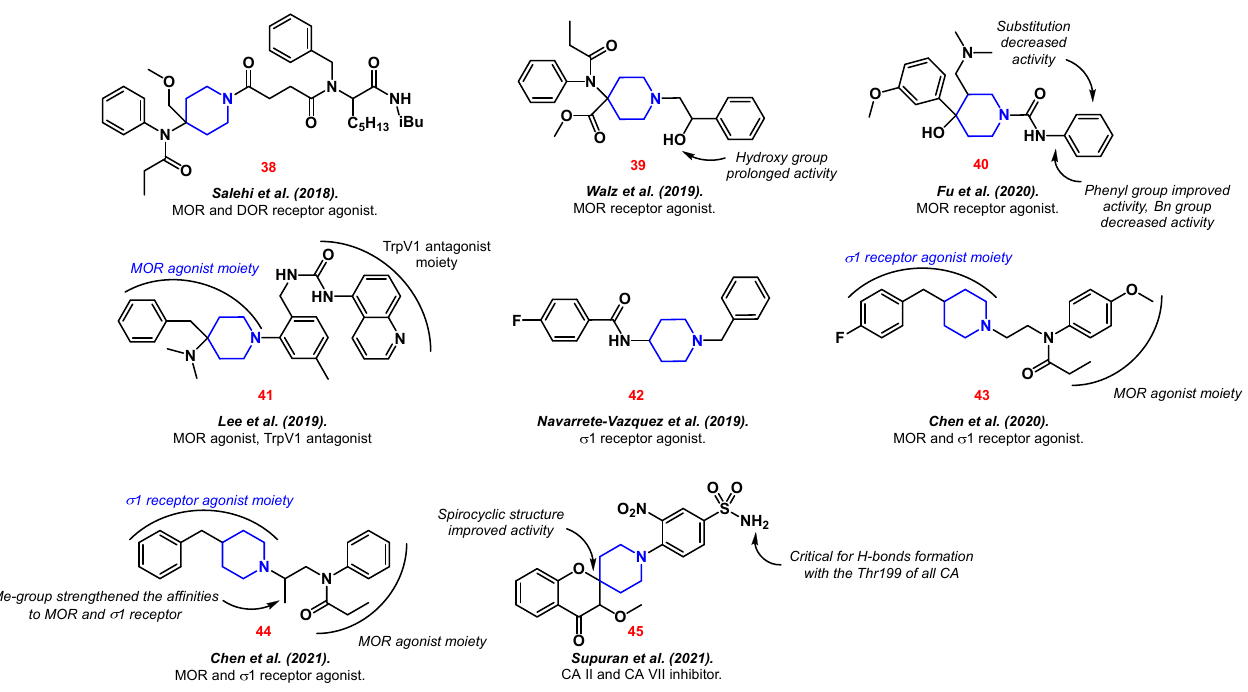
Figure 8. Piperidine derivatives as potential drugs for neuropathic pain disorders [274–277,279,281–283].